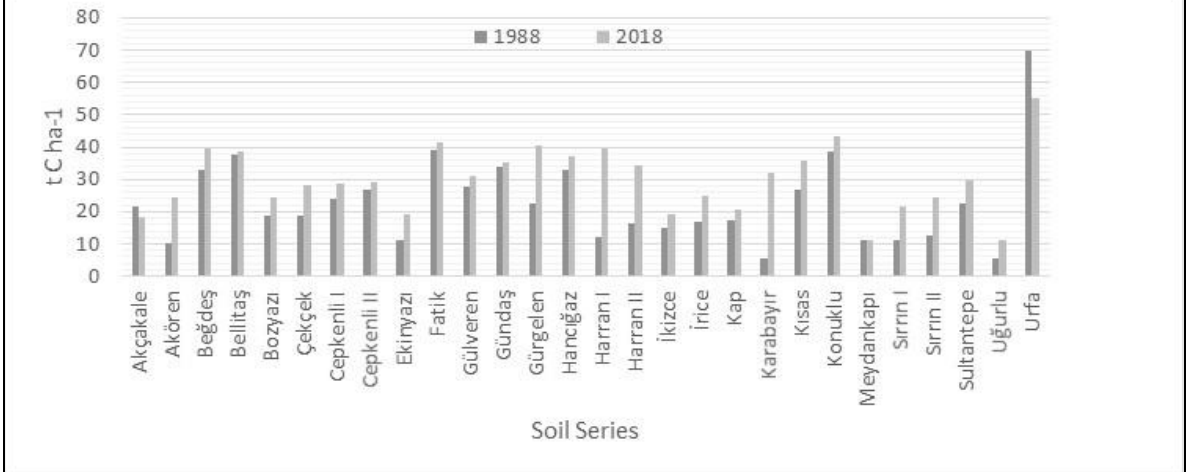
Figure 3: The soil organic carbon contents of the Harran Series in 1988 and 2018.